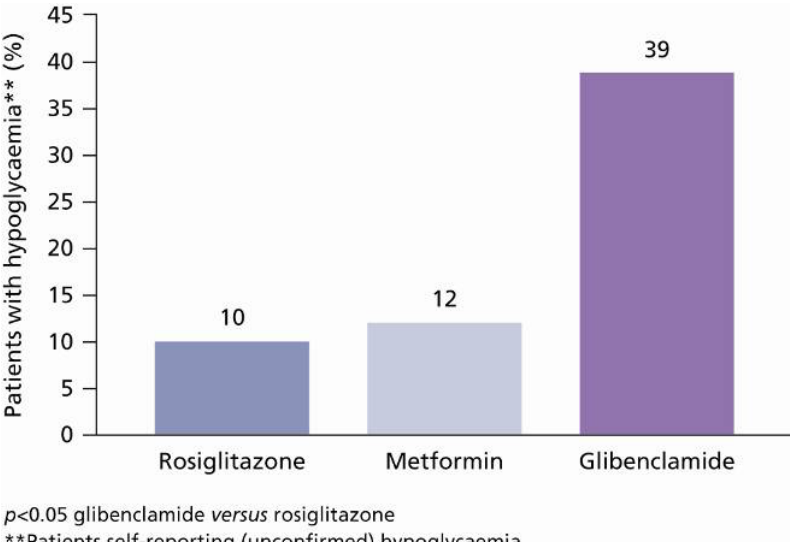
Figure 1. Hypoglycaemia as Shown in ADOPT (A Diabetes Outcome Progression Trial)